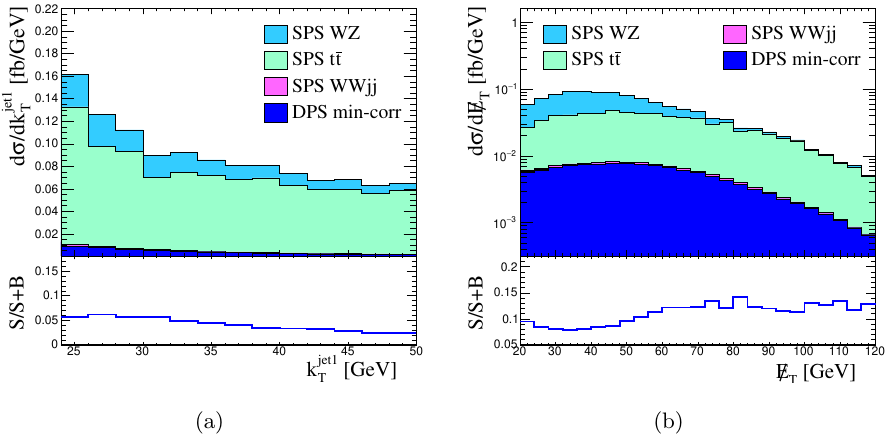
An example of usage of Underlying Event for signal-background discrimination: (a) the distribution of transverse momentum of the leading jet and (b) the distribution of the missing transverse energy in the